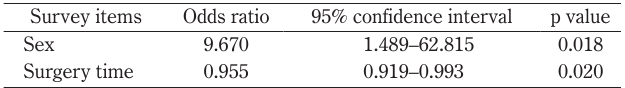
Table 2 Multiple logistic regression analysis for determination of risk factors associated with postoperative nausea and vomiting